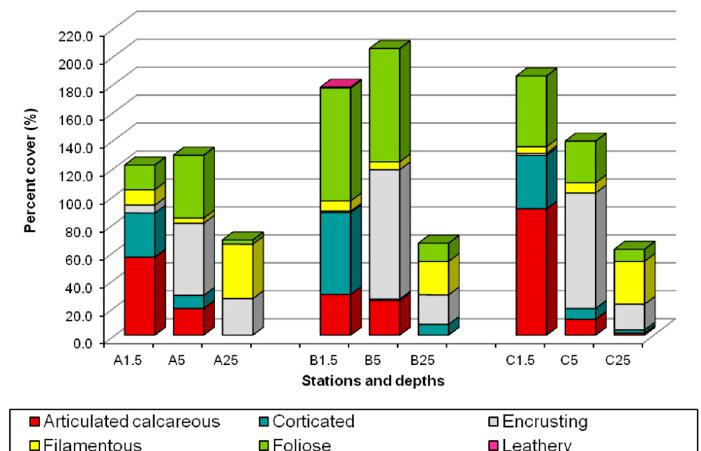
Figure 2. Mean total percent coverage of algae and algal functional-morphological groups, per stations and depths.